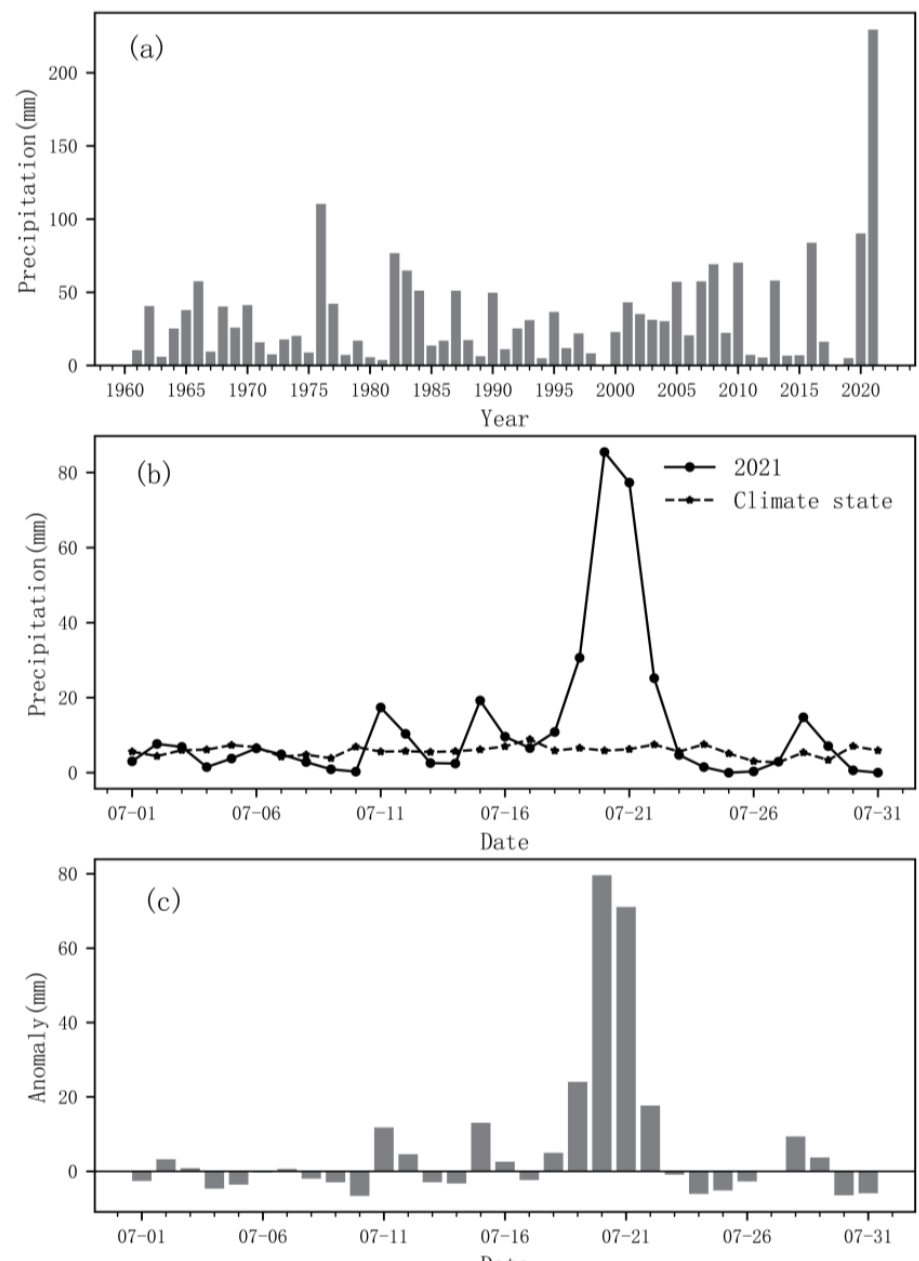
Figure 2. Time series of rainfall in Henan Province: ( a ) interannual variation of average rainfall (unit: mm) during 18–22 July from 1951 to 2021; ( b ) daily average rainfall of 2021 and climatic normal during 1–31 July (unit: mm); ( c ) daily rainfall anomalies (unit: mm) during 1–31 July 2021. Consistent with Figure 3, the water vapor from the southeast gathered and was lifted after encountering the blocking of Taihang Mountain and Funiu Mountain in western Henan. The net water vapor input was obvious, forming large-scale and high-intensity rainfall in Henan. The water vapor in Henan mainly came from the southeast direction, i.e., the net water vapor input mainly came through the eastern and southern boundaries. The net water vapor input in the whole process was 8.2 × 10 × 10 7 kg/s, and the daily net water vapor transportation in Henan gradually increased after 18 July, reaching a peak value of 17.1 × 10 × 10 7 kg/ s on 20 July (Table